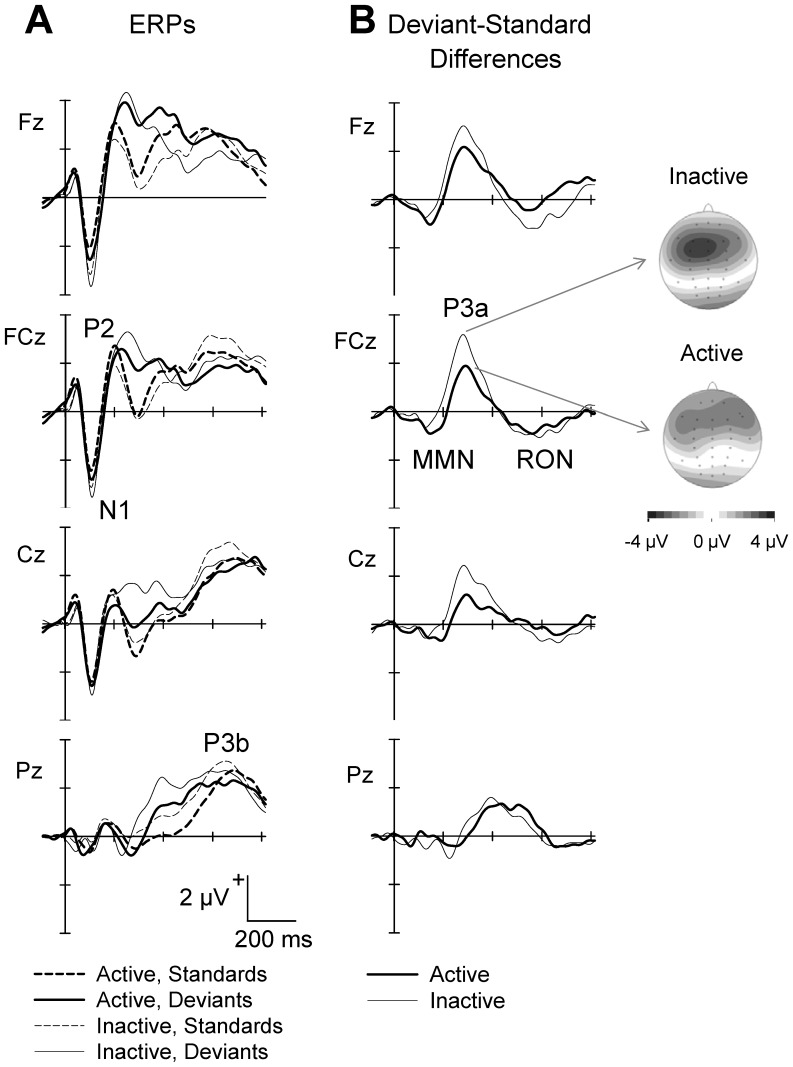
Grand average ERPs of the frequent standard tones and the rare deviant tones (A), and difference waves (deviant minus standard tones; B) at Fz, FCz, Cz, and Pz, shown for physically active and inactive participants.The vertical lines reflect the onset of the tone stimulus. ERP components (N1, P2, P3a, P3b, MMN, and RON) are marked at the waveform of maximal amplitude. The topographies represent the P3a for active (bottom) and inactive (top) participants.